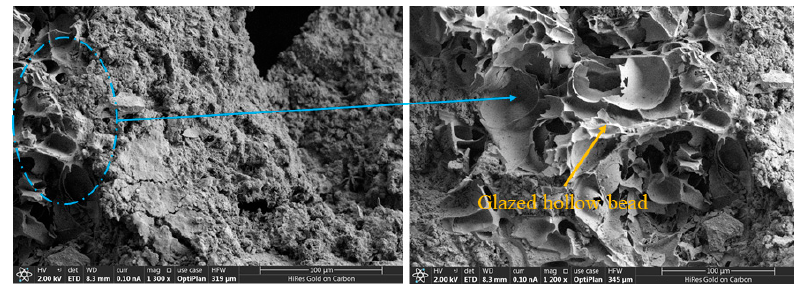
Figure 8. SEM image of the reference specimen.